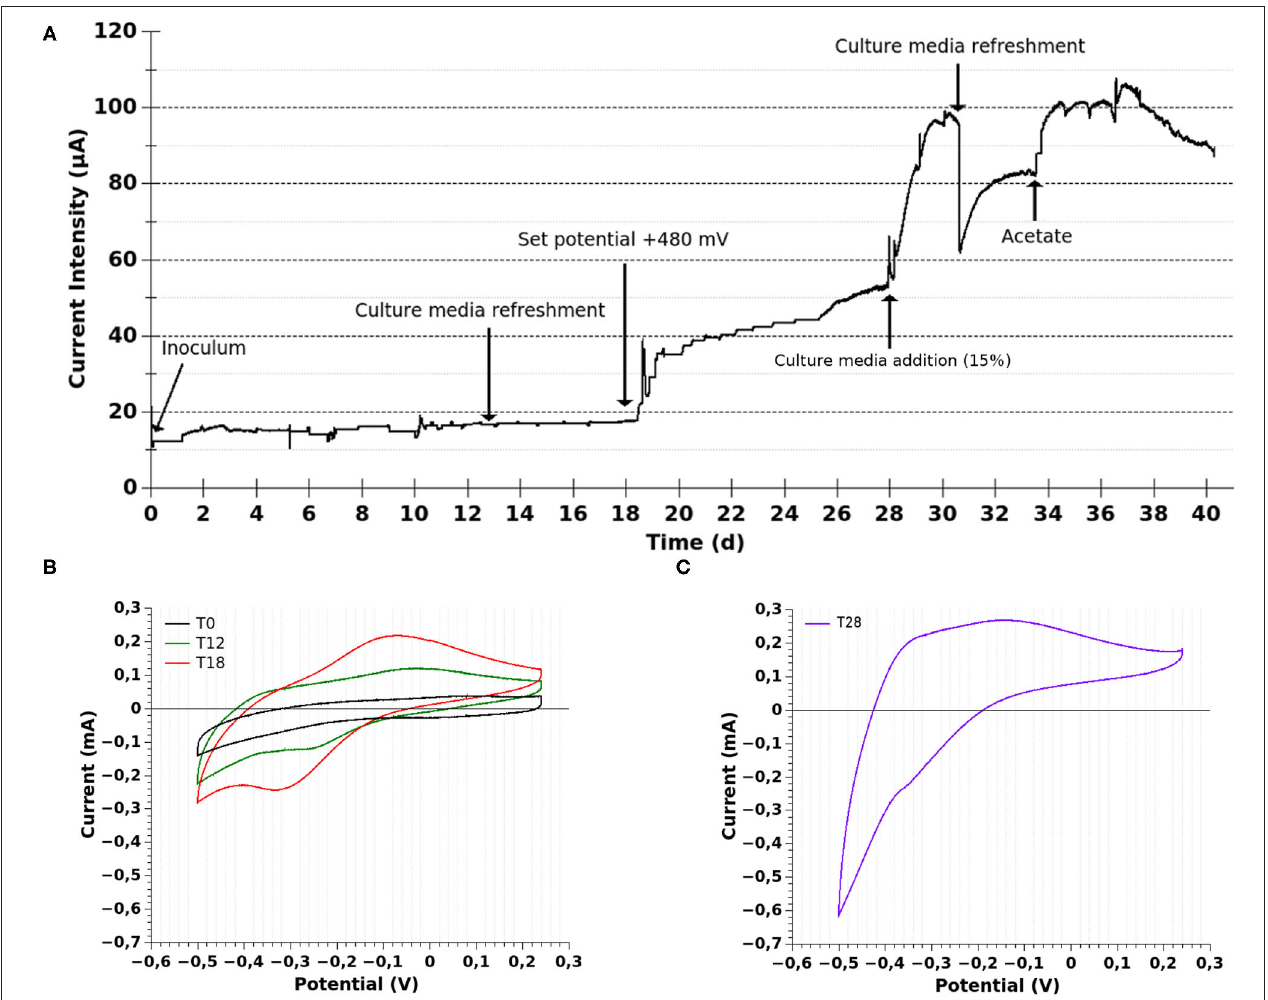
FIGURE 2 | Electrochemical characterization of MEC-a. (A) Chronoamperometry. The current evolution of the MEC employed for the selection of electrogenic microorganisms is shown. The MEC was operated in batch mode at constant temperature (30 ◦ C) during the whole experiment. The MEC was inoculated with the “enrichment” culture (Fe-reducing microorganisms, 10%). The working electrode was initially poised at 240 mV vs. Ag/AgCl and changed to 480 mV vs. Ag/AgCl at T18 (after performing CV). (B) Cyclic voltammetry (CV) was performed at 10 mV/s before inoculation (T0), at 12 (T12), and 18 (T18) days of MEC operation. (C) CV at 5 mV/s at 28 days (T28) of MEC